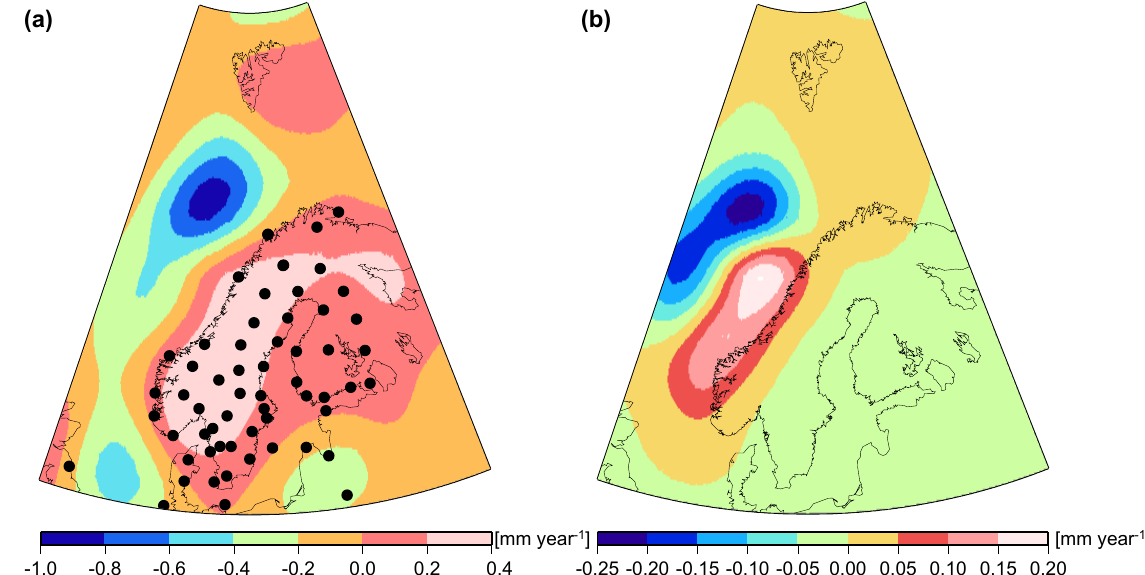
Figure 5. Uplift rates caused by sediment redistribution according to GISR models Amantov (a) and Sed1 (b) . Dots denote locations of the GPS sites of Lidberg et al. (2010). Note the different color scales. Earth model M4-16-80 is used for both cases.